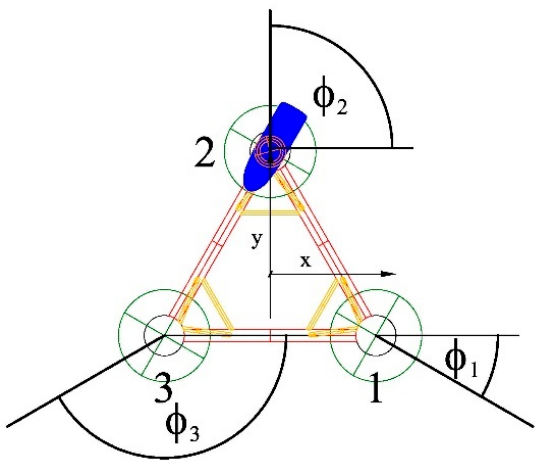
Figure 4. Curve of static stability of the device with respect to 𝑥 -axis (stable range). ( a ) Curve of static stability for the x -axis and ( b ) rotating platform around the y -axis